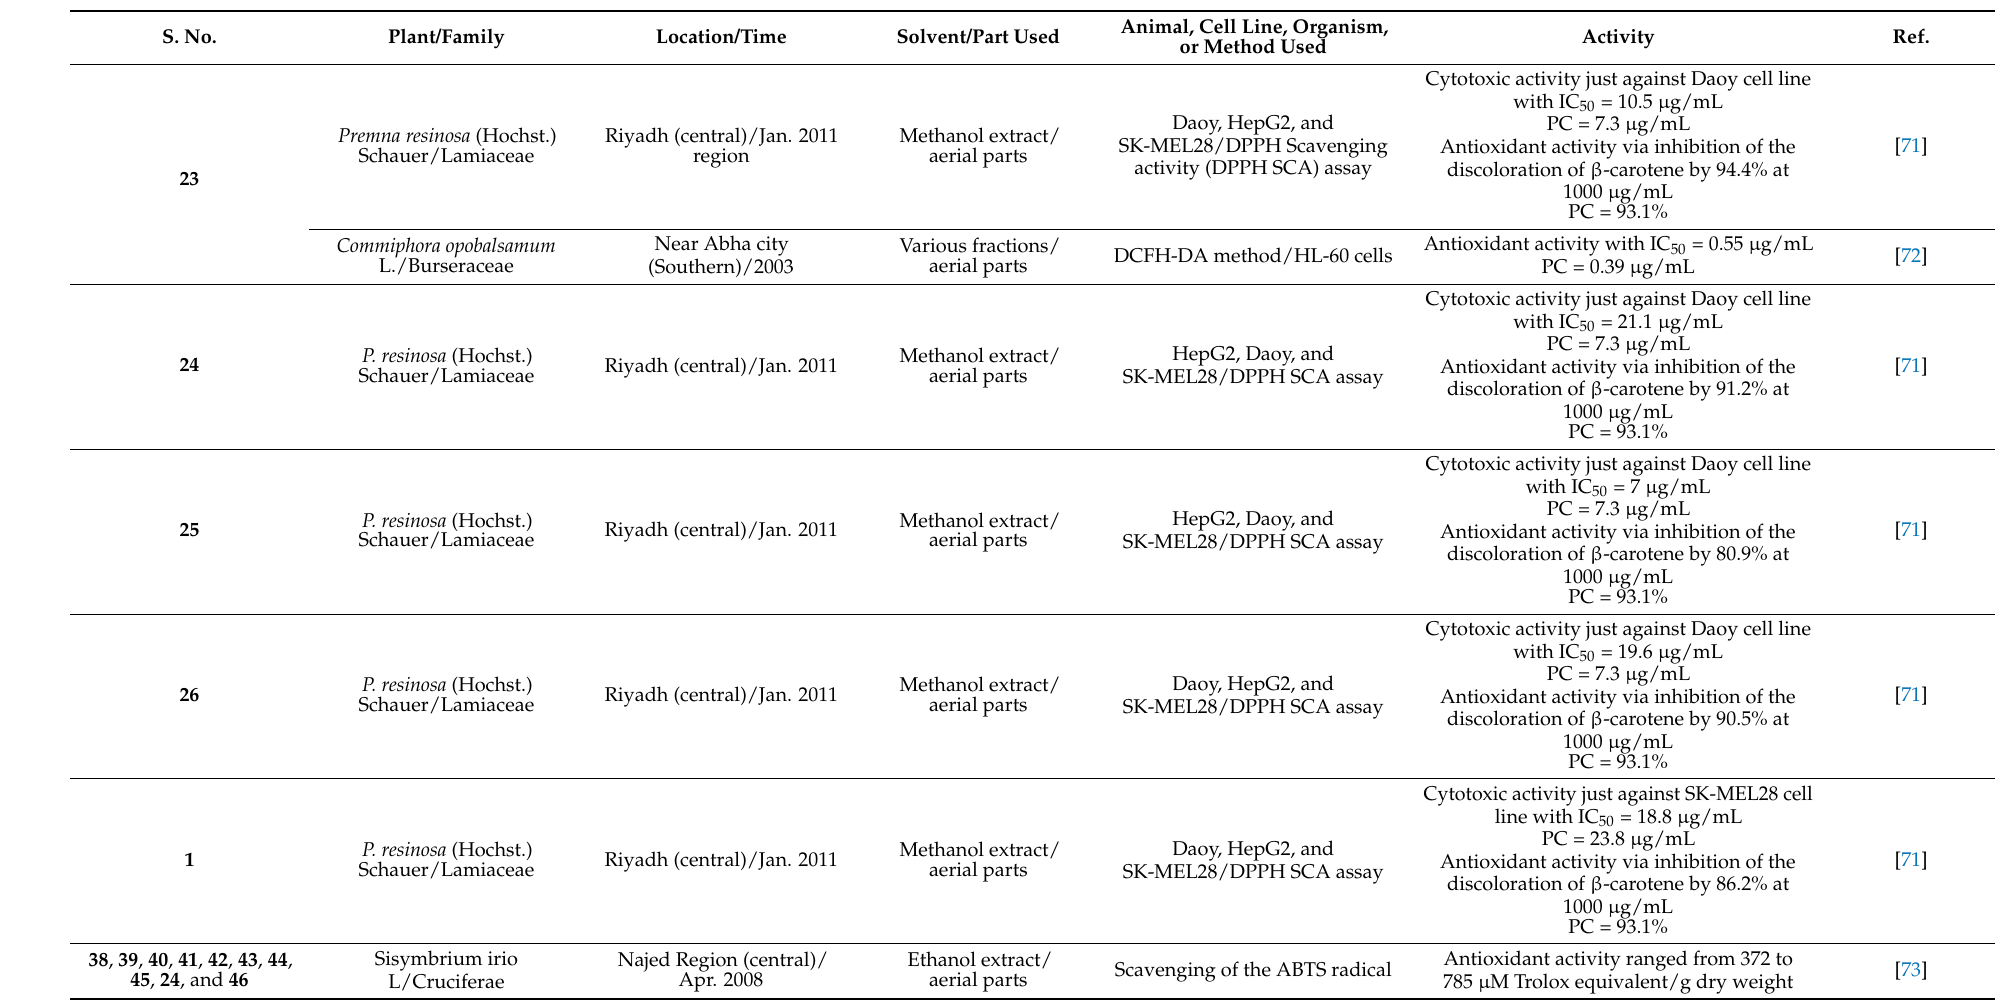
Table 1. The biological activities of isolated compounds from plants in the central and western regions of